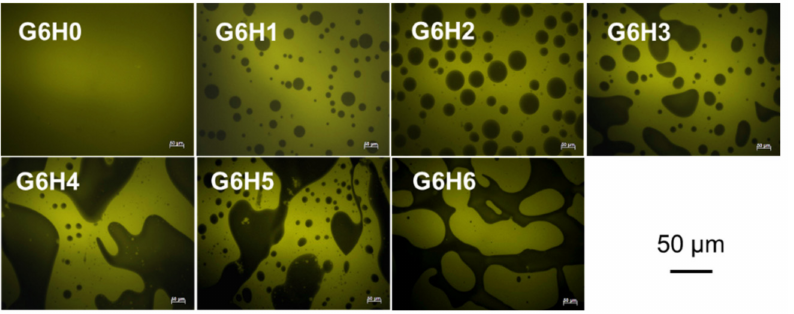
Figure 2. Fluorescence micrographs of GA/HPMC mixed systems observed at room temperature. The clear zones (yellow) correspond to the fluorescence of the labeled protein (covalently stained by FITC), and the dark ones correspond to the polysaccharide-rich